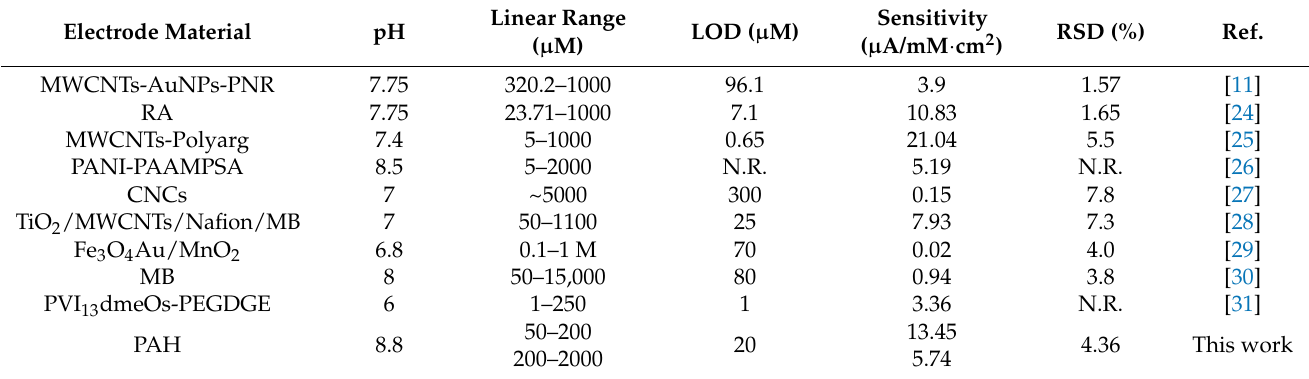
Table 1. Comparison of the performances of some ethanol biosensors based on polymer modified electrodes.